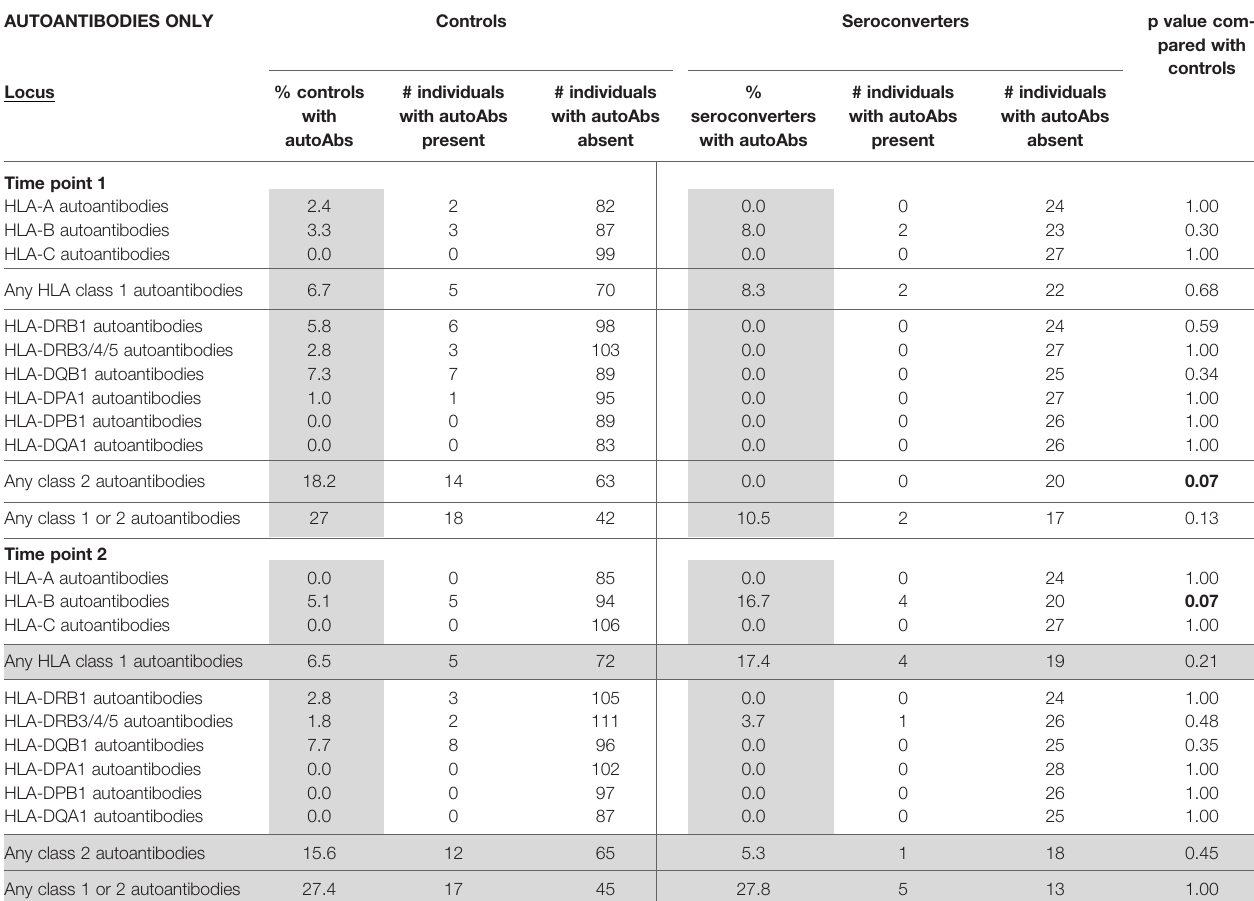
TABLE 3 | HLA autoantibodies in highly exposed persistently negative controls compared with HIV-seroconverters, at fi rst and second timepoints (n=115 highly exposed persistently seronegative controls, 28 HIV-seroconverters and 19 linked HIV-seroconverters). AUTOANTIBODIES